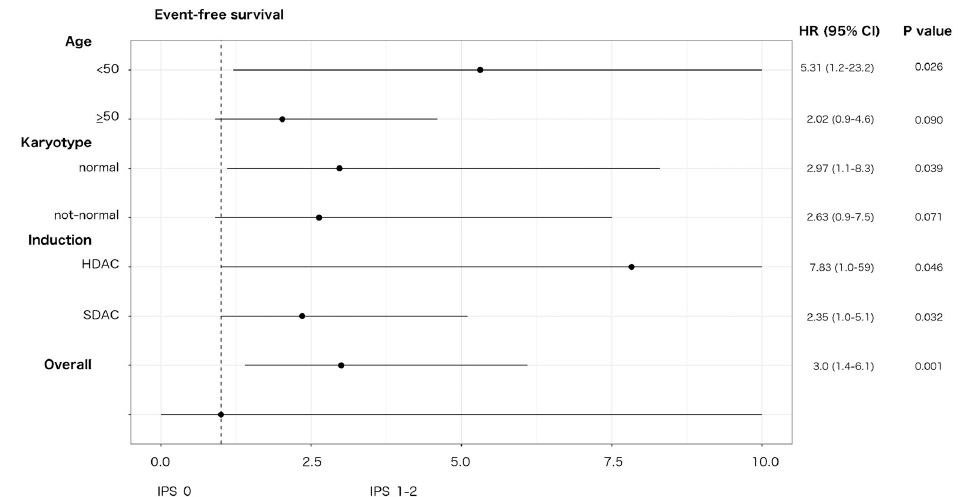
Figure 3. Survival estimates according to IPS in the triple-negative subset. Major outcomes as assessed by Kaplan–Meier curves for ( A , D ) disease-free survival, ( B , E ) overall survival, and ( C , F ) event-free survival (EFS) according to number of dysplastic lineages by immunophenotypic score (IPS) in triple- negative (TN-AML) patients. In panels ( A – C ), patients were separated in three categories; in panels D-F, IPS_1 and IPS_2 cases were grouped.